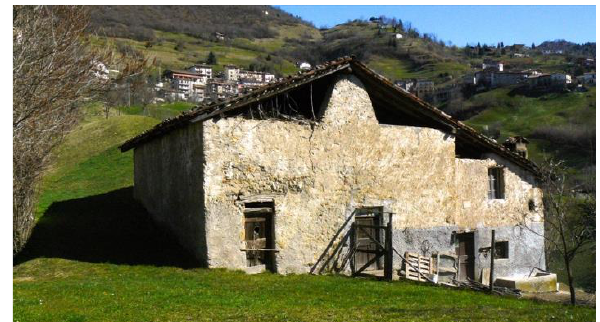
Figure 2. Farmhouse Marmentino, Brescia (Italy)